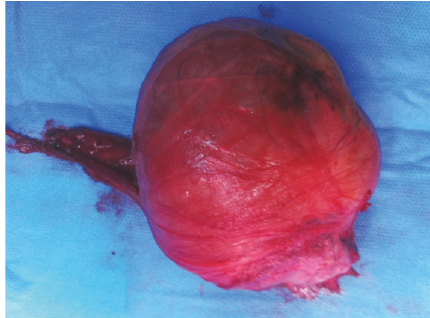
Figure 1: Operative specimen: left orchiectomy, with a 7-centimeter regular solid mass of the epididymis caput.